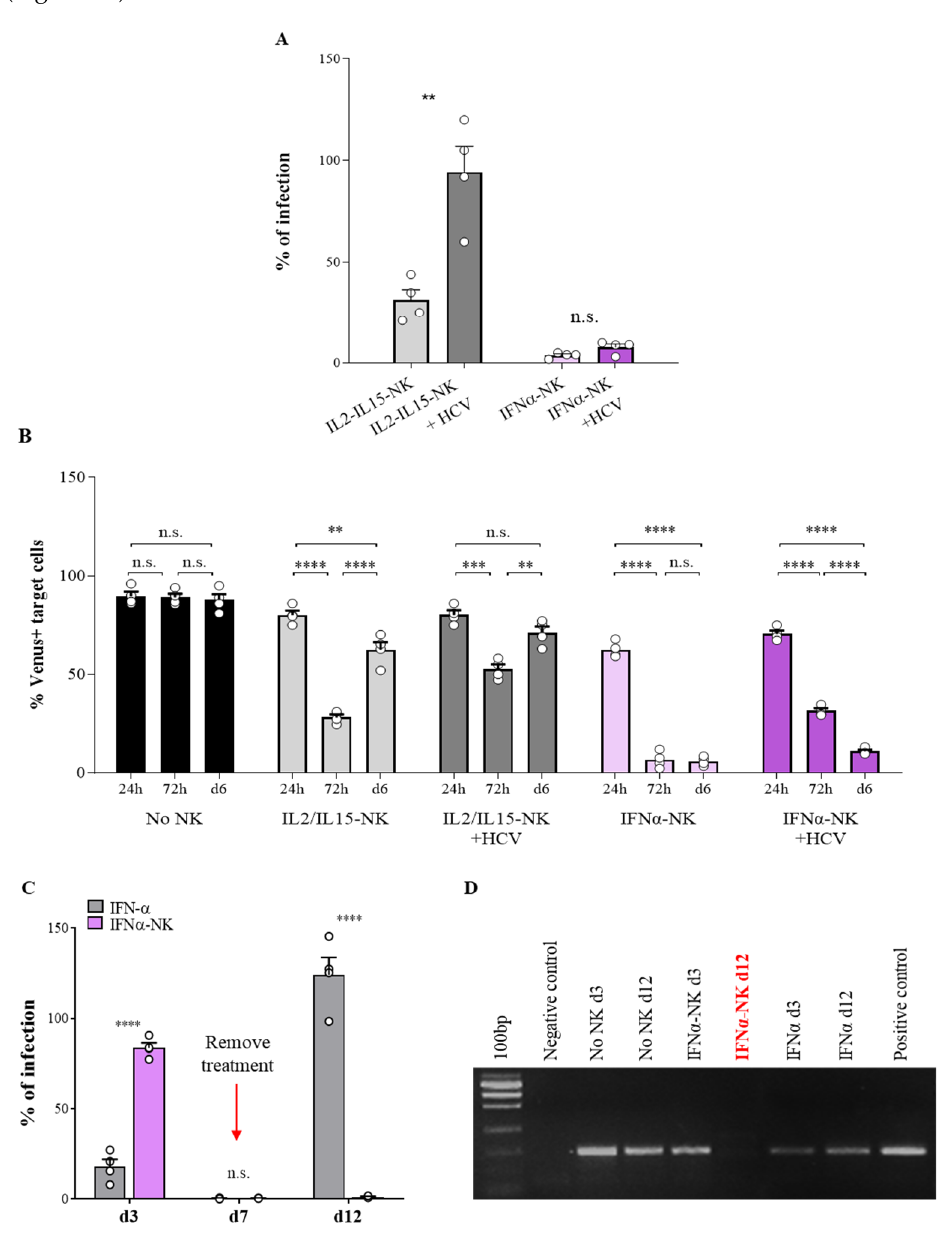
Figure 3. IFN α -NKs resisted to HCV-induced inhibition and showed durable antiviral responses in vitro. ( A ) Infection rates (percentage of control) of HCV-Huh7.5 cells co-cultured in transwells with IL2/IL15-NKs (gray bars) or IFN α -NKs (lilac bars) that had been previously exposed or not to recombinant HCV for four hours (darker gray or lilac bars). Each dot represents the average of three technical replicates from one donor ( n = 4). Mean values ± SD are shown. ( B ) Percentages of HCV- infected (Venus+) Huh7.5 target cells in co-culture with IL2/IL15-NKs (gray bars) or IFN α -NKs (lilac bars) that had been previously exposed or not to HCV (darker gray or lilac bars). Untreated target cells were used as controls (black bars). Briefly, transwells with NK cells were removed 72 h after the start of the experiment and target cells were maintained in culture in fresh medium until Day 6. Fluorescence intensities of Venus were recorded at 24 h, 72 h, and on Day 6 using flow cytometry. Each dot represents the average of three technical replicates from one donor ( n = 4). Mean values ± SEM are shown. ( C ) Infection rates (percentage of control) of HCV-Huh7.5 either co-cultured with IFN α -NKs (lilac bars) or exposed to 1 µg/mL recombinant IFN- α (gray bars), as calculated by meas- uring HCV-Ag levels on Days 3, 7, and 12. On Day 7, transwells with IFN α -NKs were re-moved, and the medium was replaced in all wells. Each dot represents the average of three technical repli- cates from one donor ( n = 4). Mean values ± SEM are shown. ( D ) Representative agarose gel electro- phoresis image showing the presence or absence of the HCV intermediate replication product